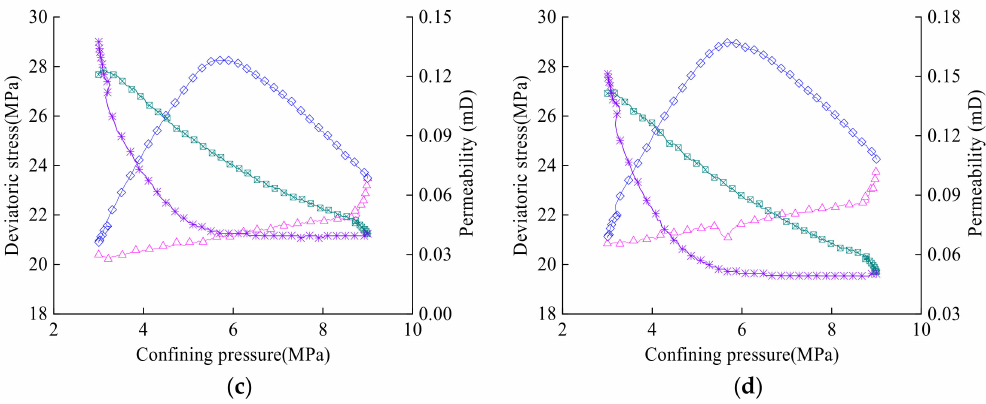
Figure 9. Deviatoric stress-confining pressure-permeability curves of water content 0.65% coal sample during loading and unloading confining pressure post-peak. ( a ) First loading and unloading ( b )